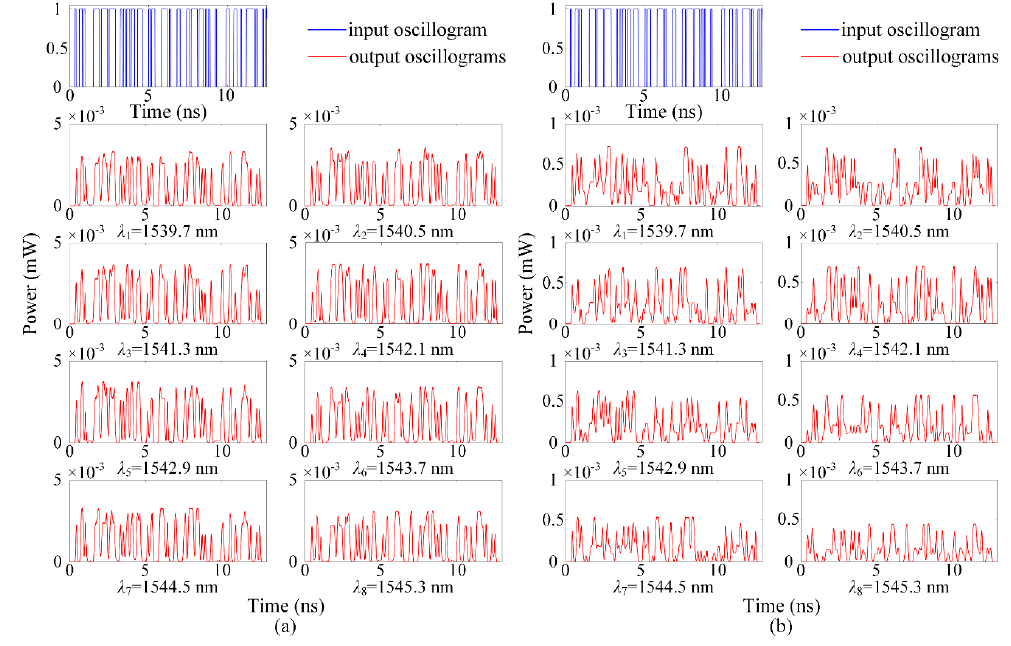
Figure 13. Signal input and output waveforms from λ 1 to λ 8 : ( a ) Using WCX optical router; ( b ) using WOPC optical router. Table 4. OSNR and crosstalk noise for each of the panel in figure 13 .